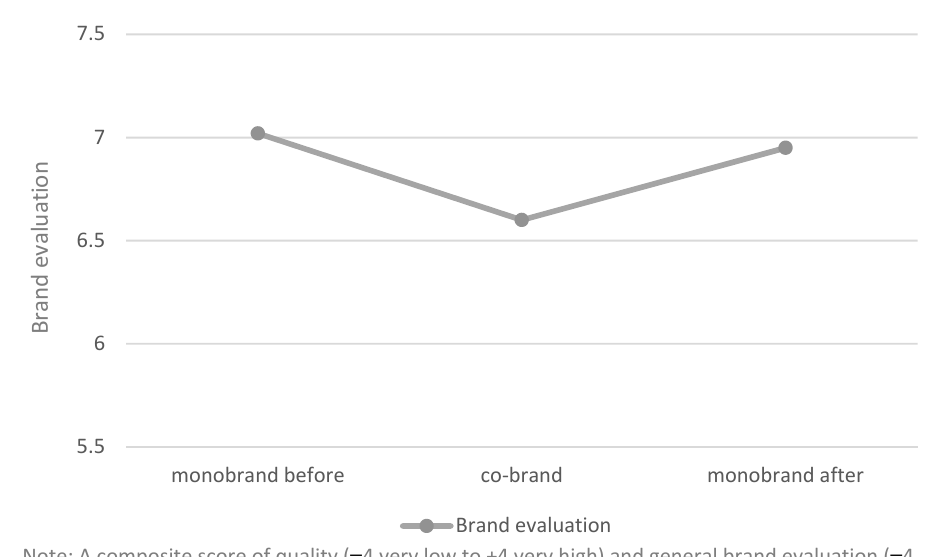
Figure 3. Mean comparisons of study 1.